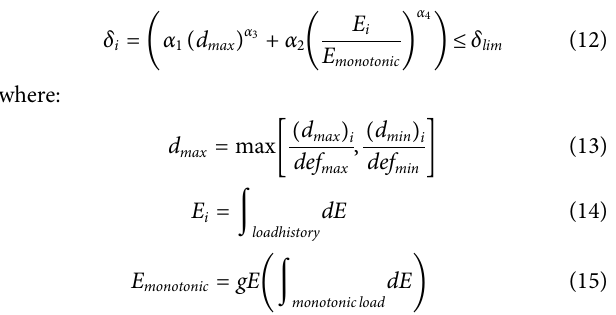
Frontiers in Materials |